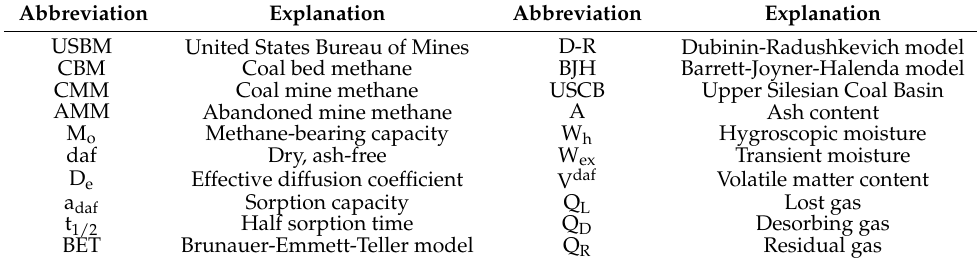
Table 1. Table of abbreviations.